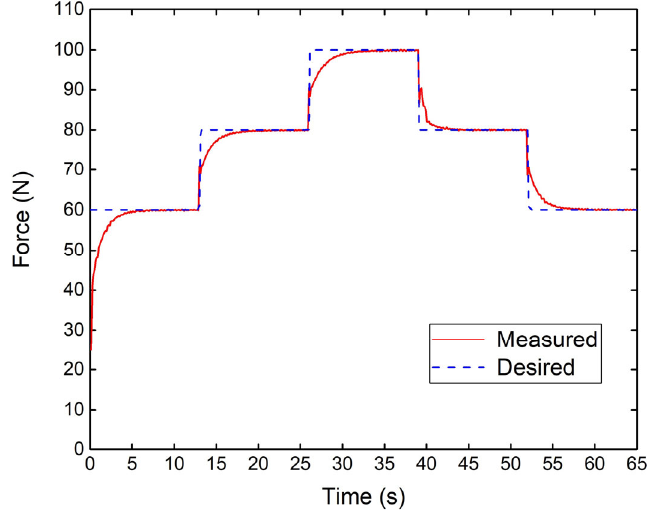
Figure 11. Tracking performance of PID control with a step-like trajectory.